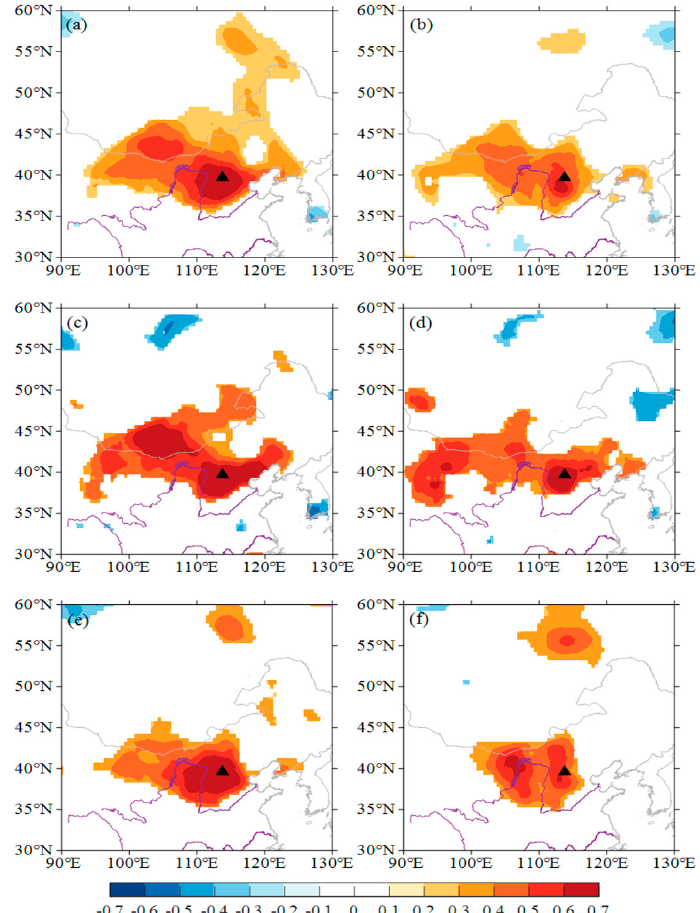
Figure 7. The spatial correlation between P J-J series and the CRU precipitation gridded data of corresponding years. ( a ) The observation during 1957–2013 AD, ( b ) the reconstruction during 1957–2013 AD, ( c ) the observation during 1957–1980 AD, ( d ) the reconstruction during 1957–1980 AD, ( e ) the observation during 1980–2013 AD, ( f ) the reconstruction during 1980–2013